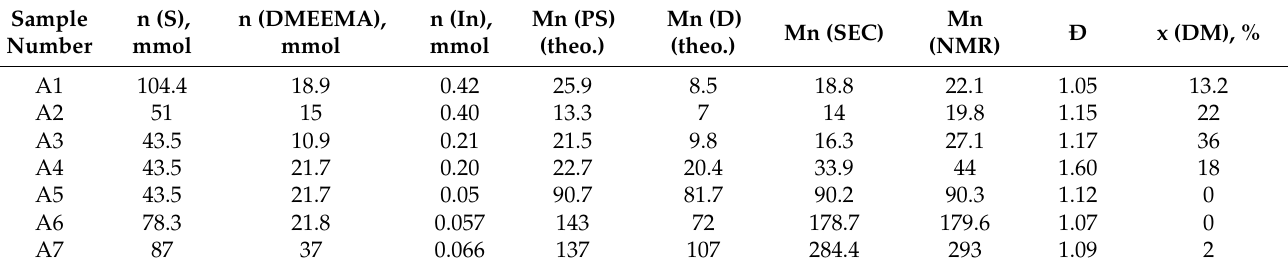
The table columns are labeled as follows: n (S), mmol—number of moles of styrene monomer in mmol. n (DMEEMA), mmol—number of moles of DMEEMA monomer in mmol. n (In), mmol—number of moles of the initiator (sec-buthyl-lithium) in mmol. Mn (PS) (theo.)— theoretical expectation for the number average molecular weight of the PS blockl. Mn (D) (theo.)—theoretical expectation for the number average molecular weight of the PDMEEMA block. Mn (SEC)—number average molecular weight of PS block. Mn (NMR)—number average molecular weight of the diblock-copolymer (apparent molecular weight versus polystyrene calibration obtained by the SEC). Ð—dispersity, calculated as Mw/Mn (both of molecular weights are apparent versus polystyrene calibration). x (DM)—molar fraction of the DMEEMA block, obtained from the 1 H NMR